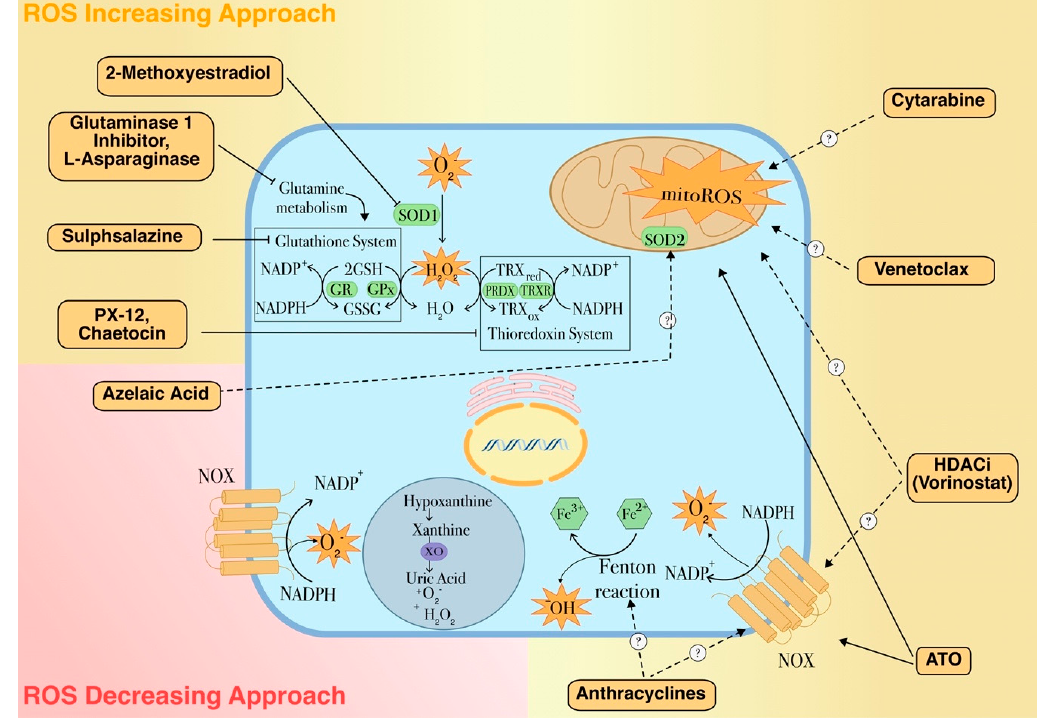
Figure 4. ROS-dependent therapeutic agents for leukemia treatment. The mechanism of action and the molecular targets of pro- or antioxidant drugs used in leukemia are shown. Along with conventional treatments, this figure depicts some promising examples of these approaches. 2-Methoxyestradiol (2ME2), a naturally occurring estrogen metabolite with antiproliferative and antiangiogenic activities is able to induce apoptosis through a ROS-dependent mechanism. Also, this drug is able to target LSCs by inhibiting the transcriptional activity of HIF-1 α , that is found over-expressed in LSCs under hypoxic conditions, thus down-regulating pro-leukemic HIF-1 α target genes, including the vascular endothelial growth factor (VEGF) [130,131]. L-asparaginase treatment has recently been reported to induce autophagy by promoting apoptosis and cell growth inhibition in AML cells and has synergistic effects with conventional AML chemotherapies [132]. The thiodioxopiperazine natural product chaetocin (SUV39H1 inhibitor) is a competitive substrate and inhibitor of thioredoxin reductase and in this way induces cellular oxidative stress. In addition, as inhibitor of SUV39H1, a co-factor of the transcription factor RUNX1 which has an important role in the regulation of proliferation and self-renewal of hematopoietic stem cells, chaetocin also promotes differentiation of AML cells and has synergistic effects with HDAC inhibitors [133,134]. Dotted arrows with question marks indicate plausible mechanisms of action. Full and dashed arrows indicate well- established or hypothetical molecular mechanisms,